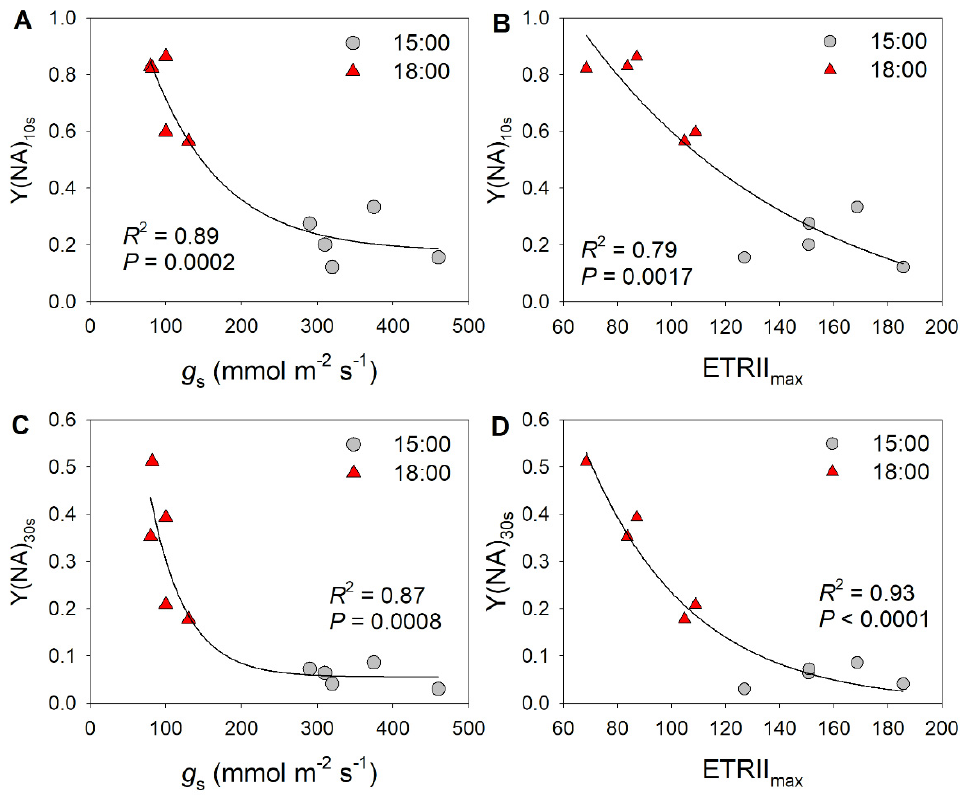
Figure 2. Exploration of correlations between PSI redox state and photosynthetic parameters: relationship between ( A ) stomatal conductance ( g s ) and Y(NA) after transition from low to high light for 10 s (Y(NA) 10 s ), between ( B ) maximum electron transport rate through PSII (ETRII max ) and Y(NA) 10 s , between ( C ) stomatal conductance ( g s ) and Y(NA) after transition from low to high light for 30 s (Y(NA) 30 s ), and between ( D ) ETRII max and Y(NA) 30 s in tomato leaves. The data for Y(NA) were taken from the second low/high light cycle, as shown in Figure 1.